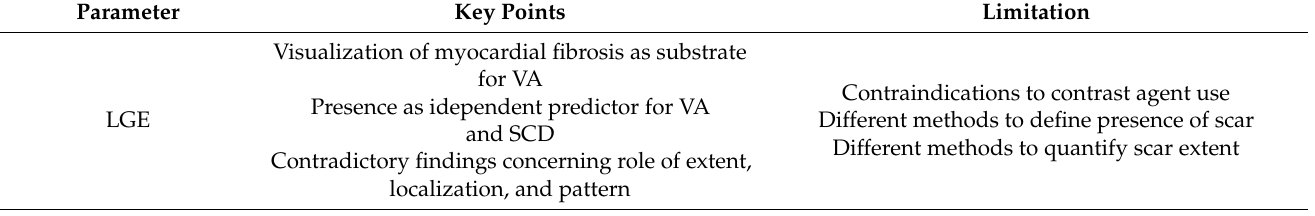
Table 1. Overview of CMR parameters and their limitations in risk assessment for